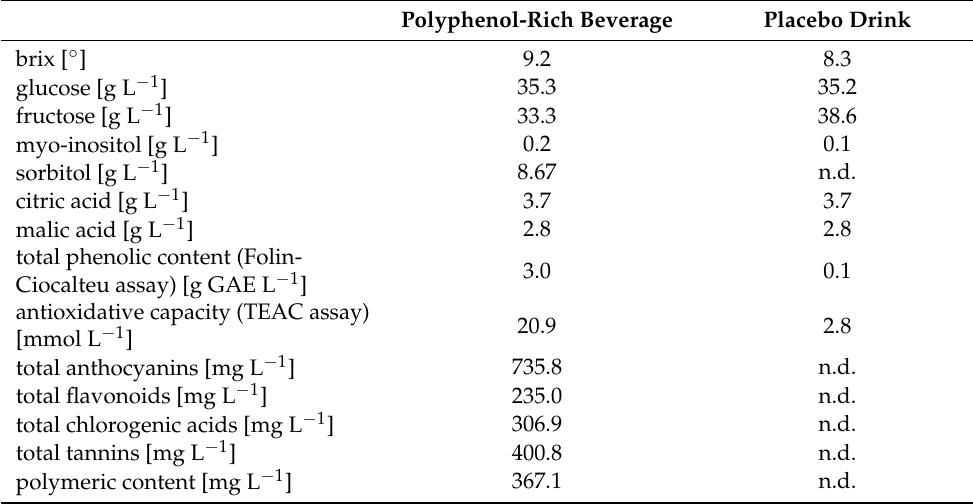
Table 1. The composition of the two study